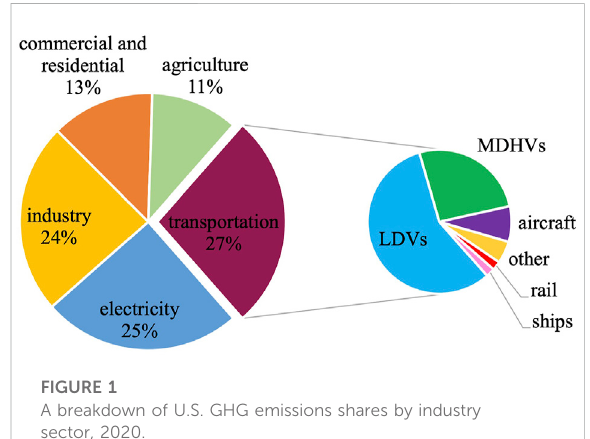
FIGURE 1 A breakdown of U.S. GHG emissions shares by industry sector, 2020.